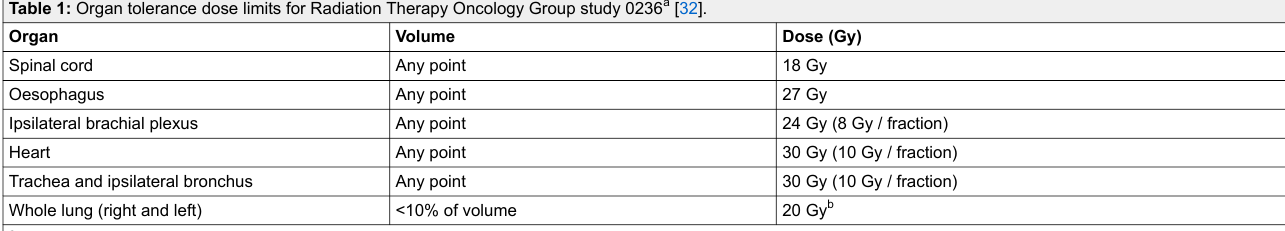
Table 1: Organ tolerance dose limits for Radiation Therapy Oncology Group study 0236 a [32]. Organ Volume Spinal cord Ipsilateral brachial plexus Heart Trachea and ipsilateral bronchus Whole lung (right and